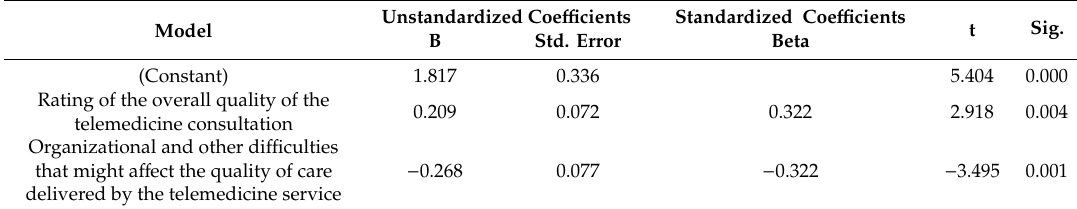
Table 5. Multivariate Linear